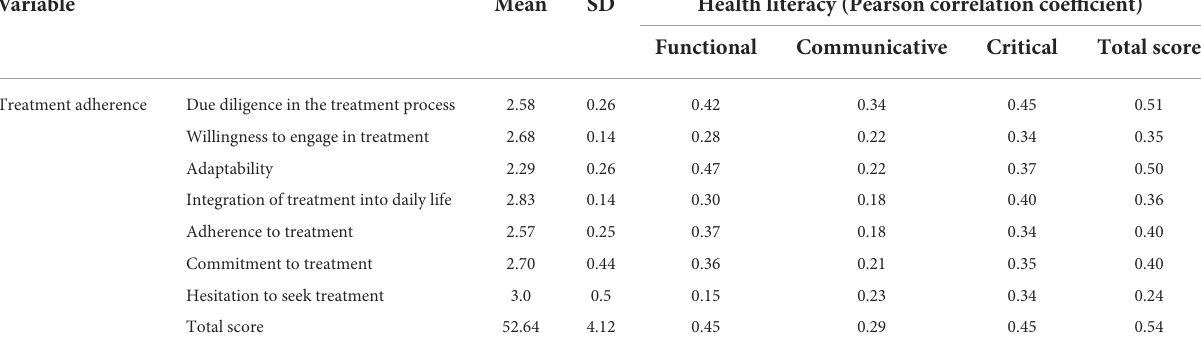
TABLE 3 Comparison of the relationship between health literacy and treatment adherence among study participants. Variable Mean SD Health literacy (Pearson correlation coefficient) Functional Communicative Critical Total score Treatment adherence Due diligence in the treatment